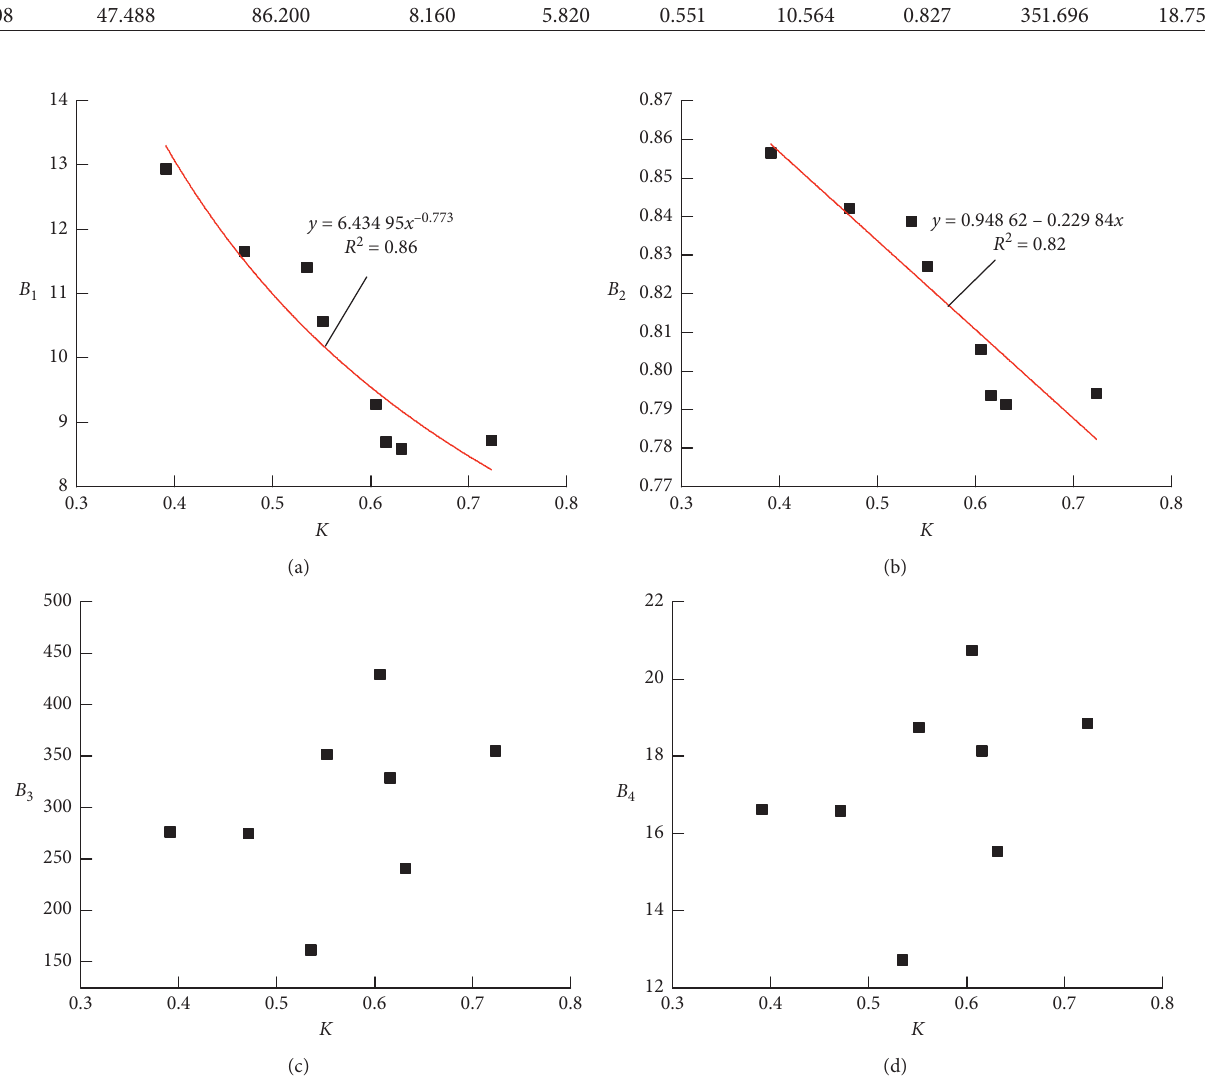
Figure 5: Relationship between crack initiation stress ratio K of limestone and different brittleness indexes: (a) B